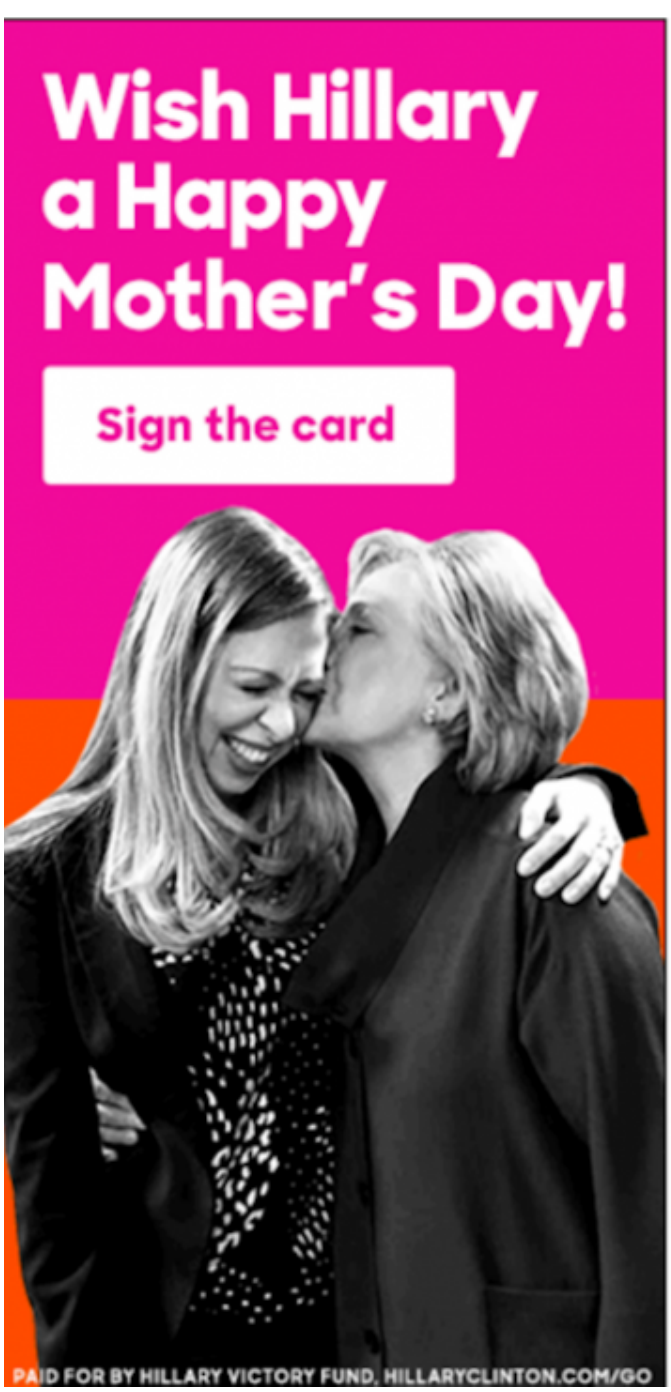
Figure 2: Hillary Clinton digital campaign advertisement Source: Hillary for America Design